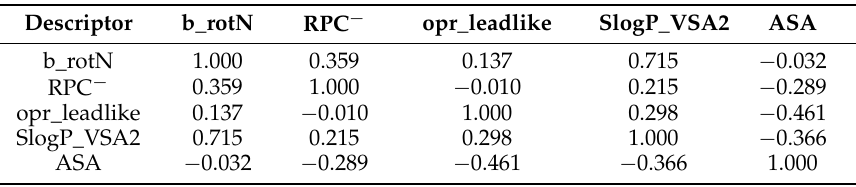
Table 2. The correlation matrix of